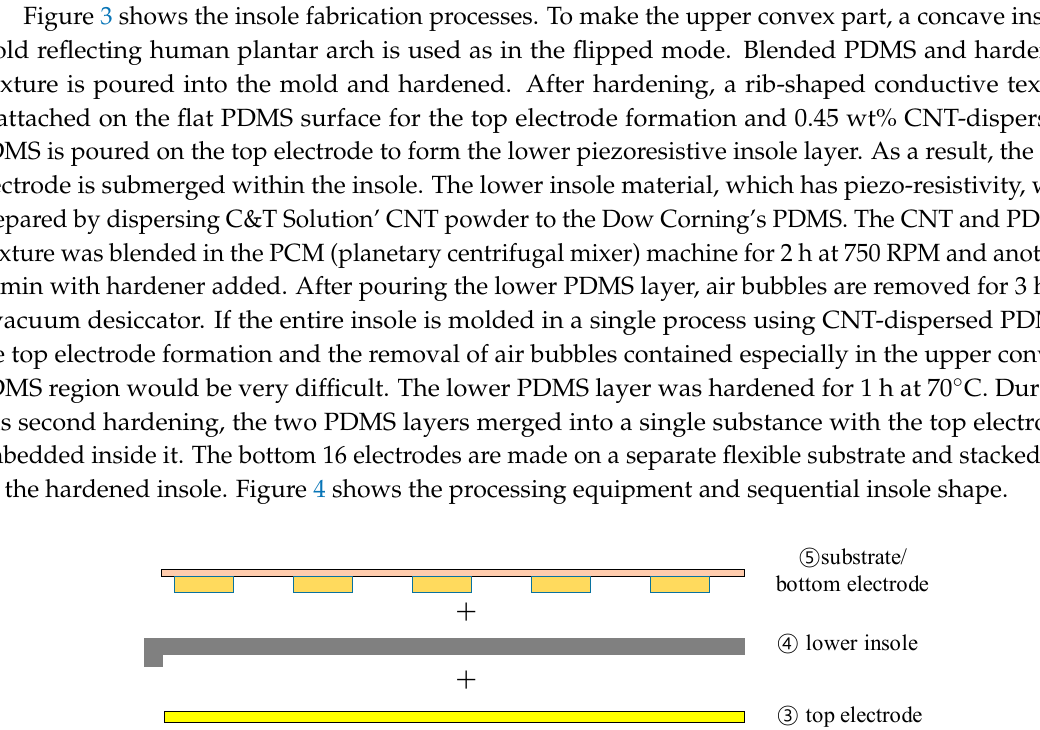
Figure 2. Structure of the polymer-based smart insole.